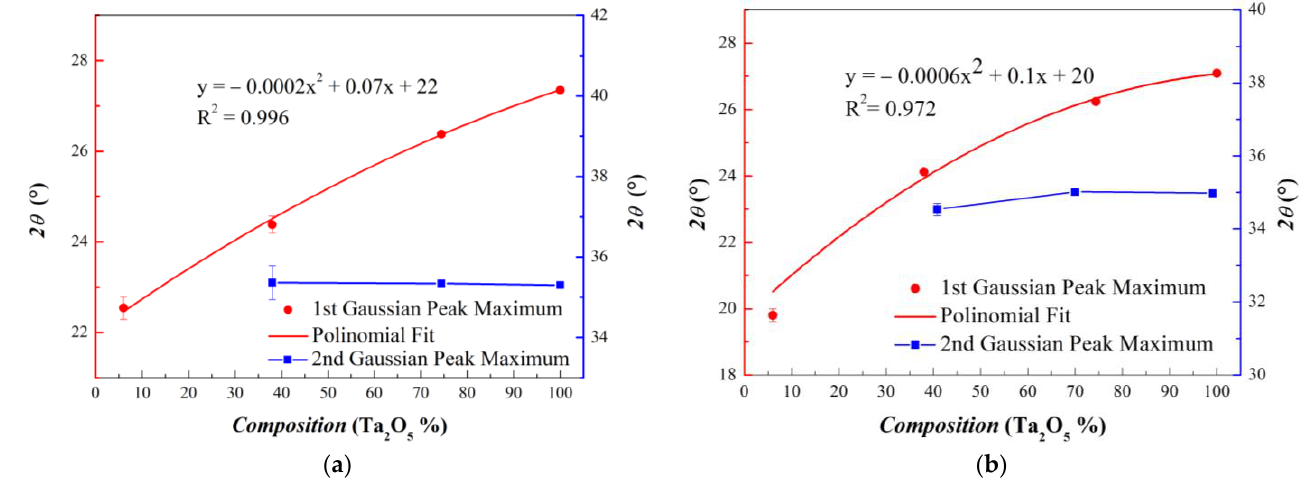
Figure 4. Trends of the Gaussian maxima from the best fit to GIXRD series acquired with Slit widths equal to 0.6 mm ( a ) and 2.0 mm ( b ).